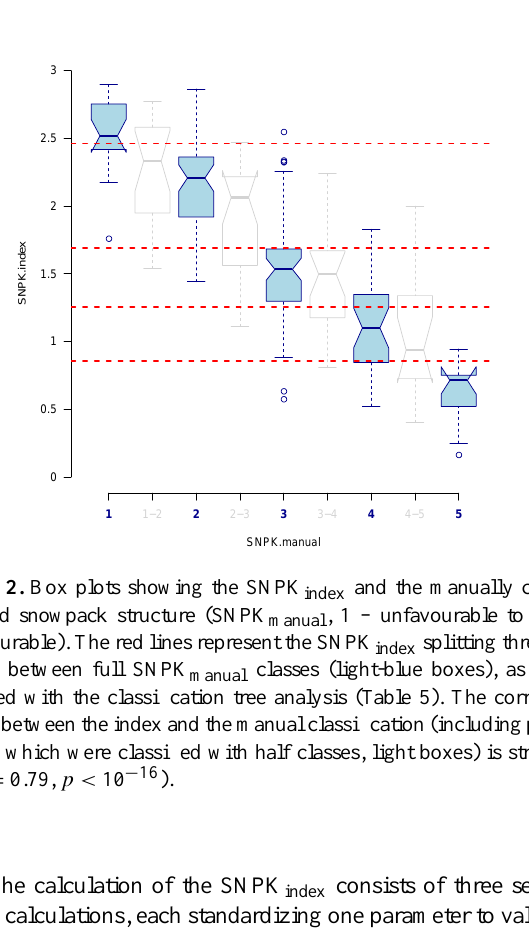
Fig. 1. Box plots showing variables selected for the snowpack index (SNPK index ) and their distribution relative to the manually classified snowpack structure (SNPK manual ): threshold sum approach for layers (left) and layer interfaces (centre) and depth of persistent weak layer (right). All three variables are strongly correlated to SNPK manual and moderately correlated to each other.